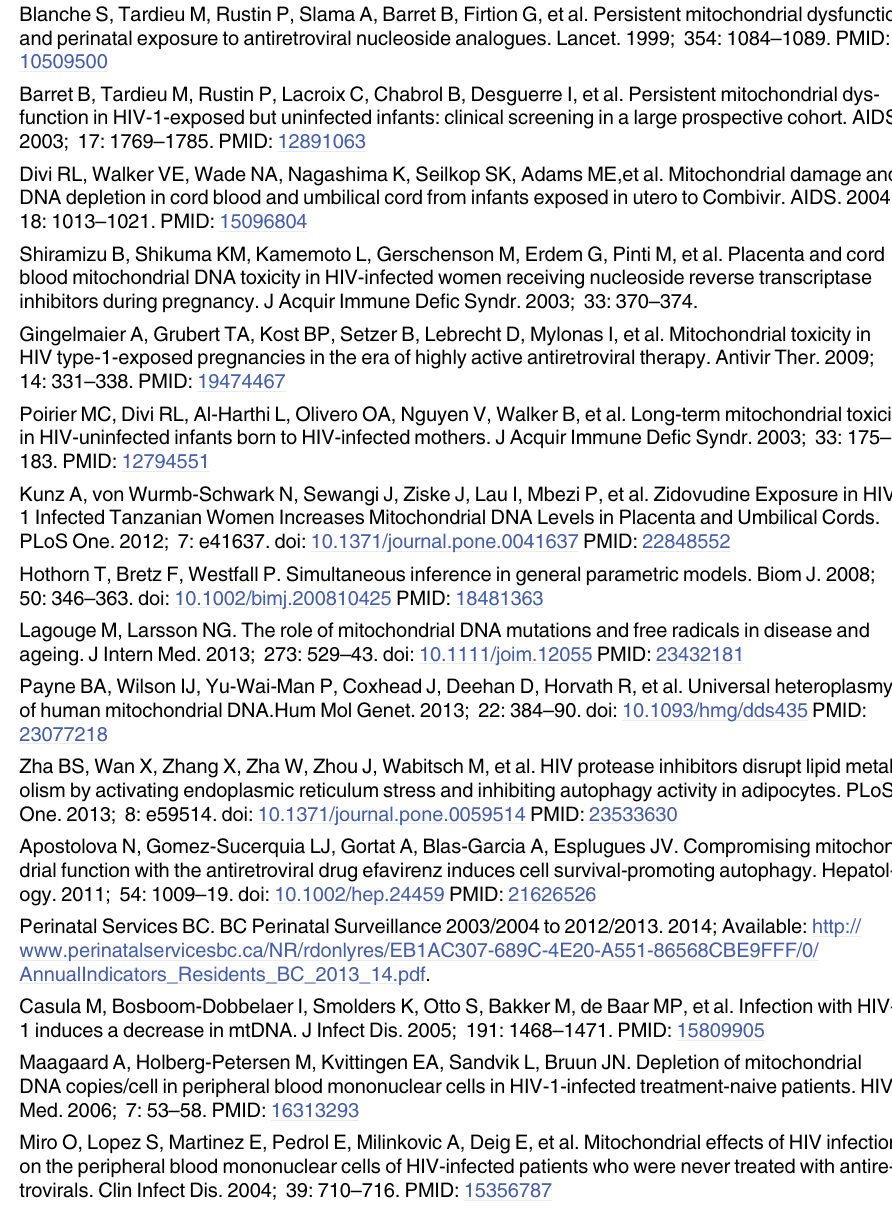
PLOS ONE | DOI:10.1371/journal.pone.0135041 August 6,